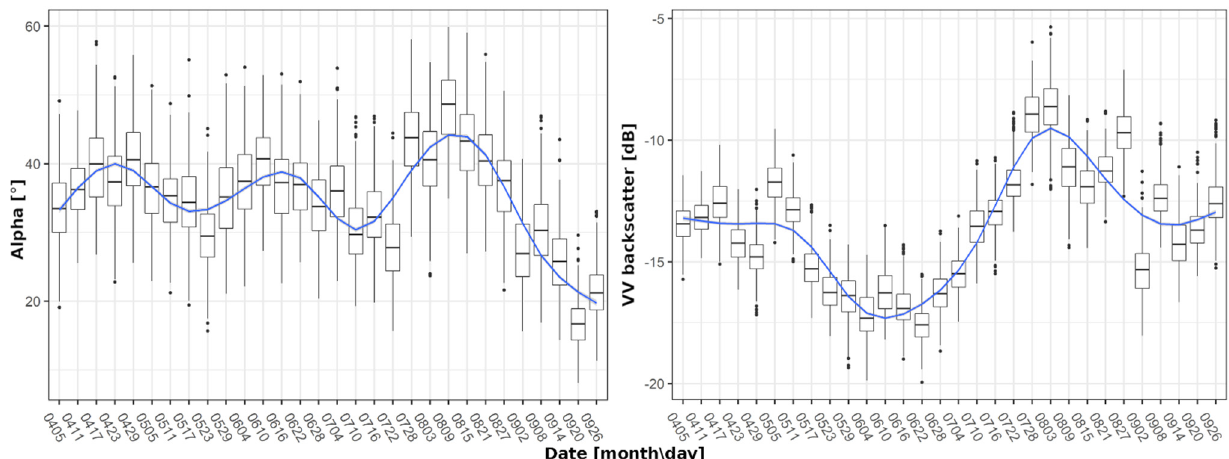
Figure 3. Exemplary smoothing of wheat signatures for Alpha ( left ) and VV backscatter ( right ) using the locally weighted scatterplot smoothing (LOESS) algorithm.